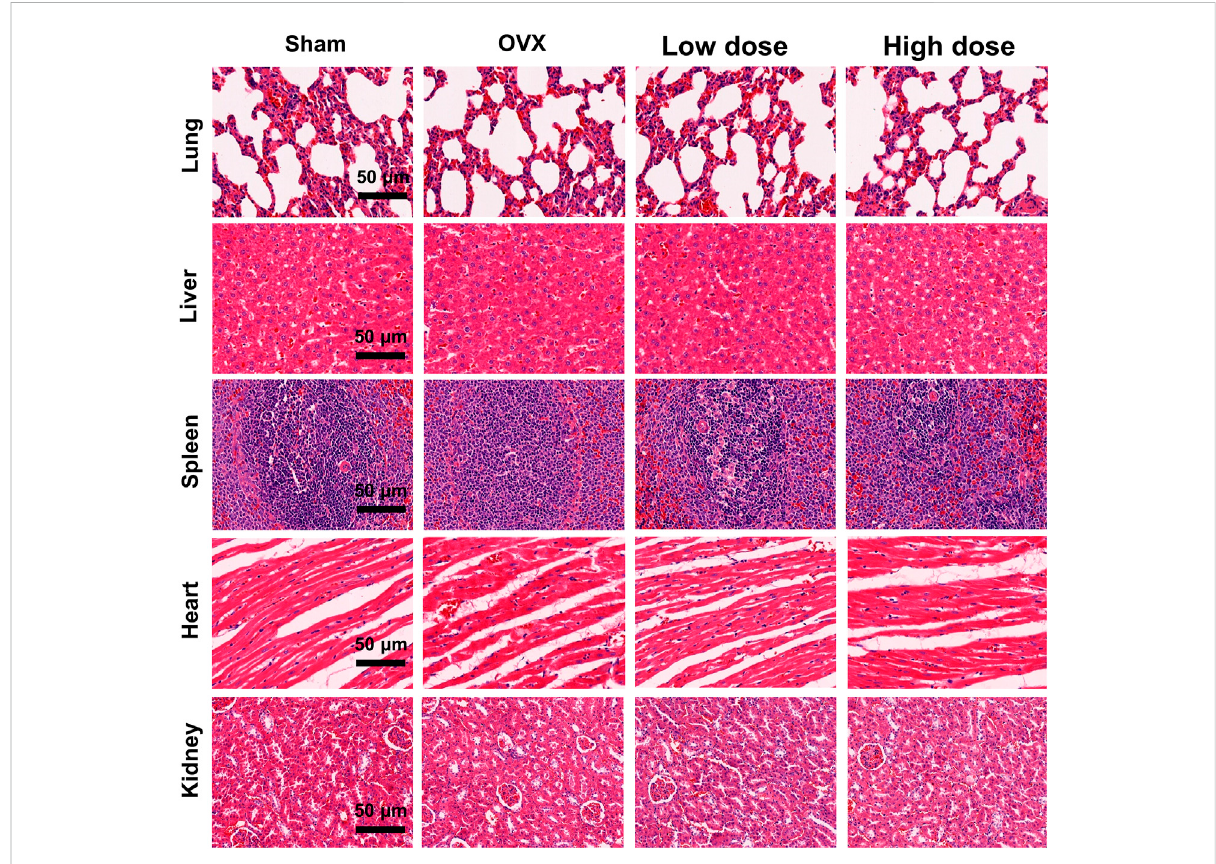
H&E staining of major organs. No obvious pathological changes were observed in the lungs, liver, spleen, heart or kidneys between the four groups, which indicatesthat 200and 500 ug/kg omaveloxolone didnot cause signi fi cant organ toxicityin ratsafter 8weeks of treatment.(scalebar, 50 μ